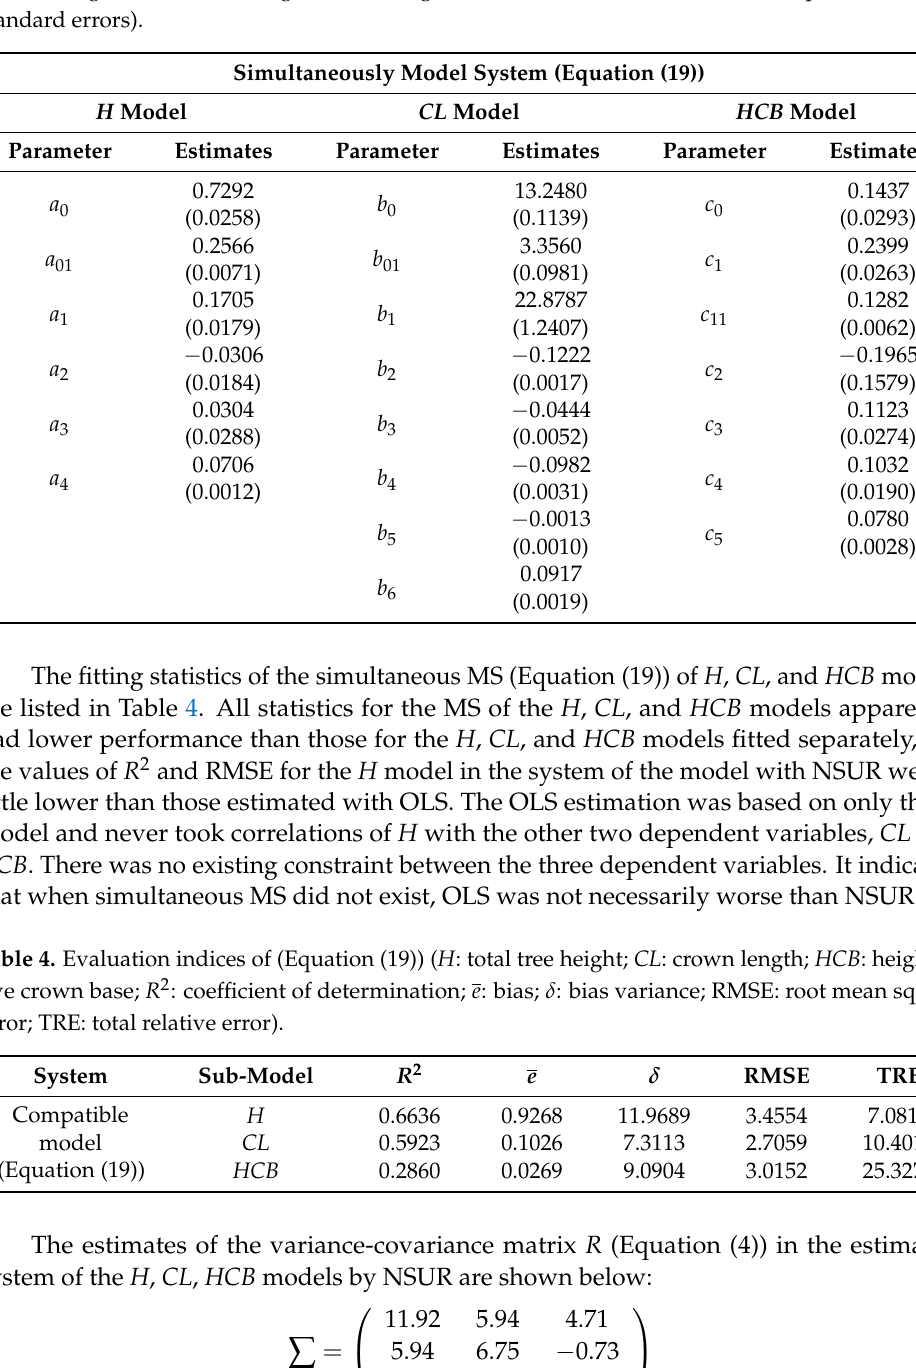
Table 3. Parameter estimates of a system of the models of H , CL , HCB (Equation (19)) ( H : to- tal tree height; CL : crown length; HCB : height to live crown base; values in the parenthesis are standard errors).